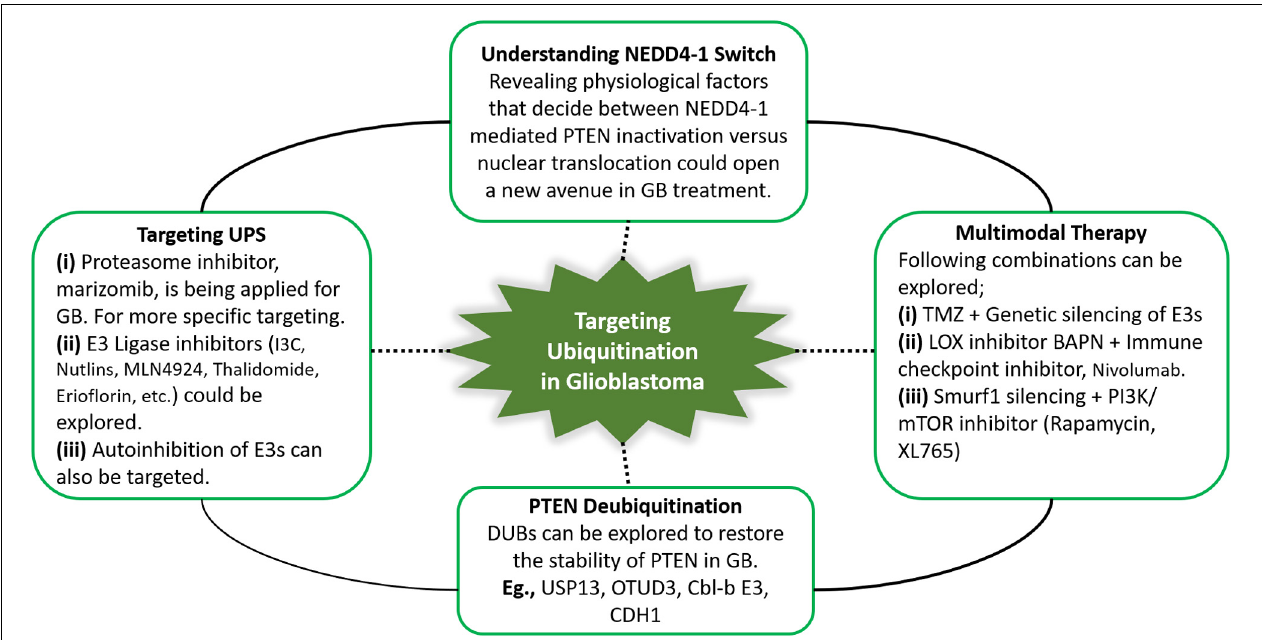
FIGURE 4 | Summary of the potential future directions for targeting PTEN ubiquitination in GB. Therapeutic approaches targeting ubiquitin-proteasome system, specifically ubiquitination can yield promising outcomes by restoring PTEN functions. In this context, PTEN deubiquitinating enzymes, and proteasome and E3 ligase inhibitors can be explored in glioblastoma treatment. NEDD4-1 is the most extensively studied E3 ligase. NEDD4-1 causes PTEN degradation via polyubiquitination, while regulates PTEN nuclear shuttling via monoubiquitination. Improved insights into physiological signals that regulate the NEDD4-1 switch of PTEN destruction and nuclear translocation can reveal potential therapies. Keeping in view the heterogeneity in glioblastoma and the involvement of numerous oncogenic players, multitarget combination treatment for glioblastoma should be explored.